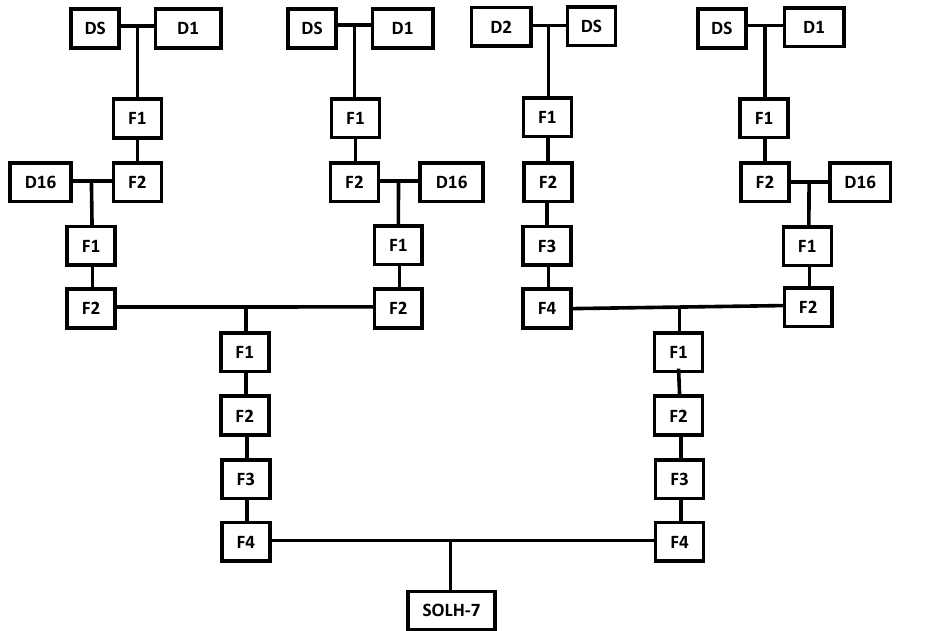
Fig 1 . A typical example of an experimental diploid potato hybrid “SOLH-7”, obtained by various crossing among the diploid founders D1, D2 and D16 and the Sli-donor DS (see Lindhout et al.,